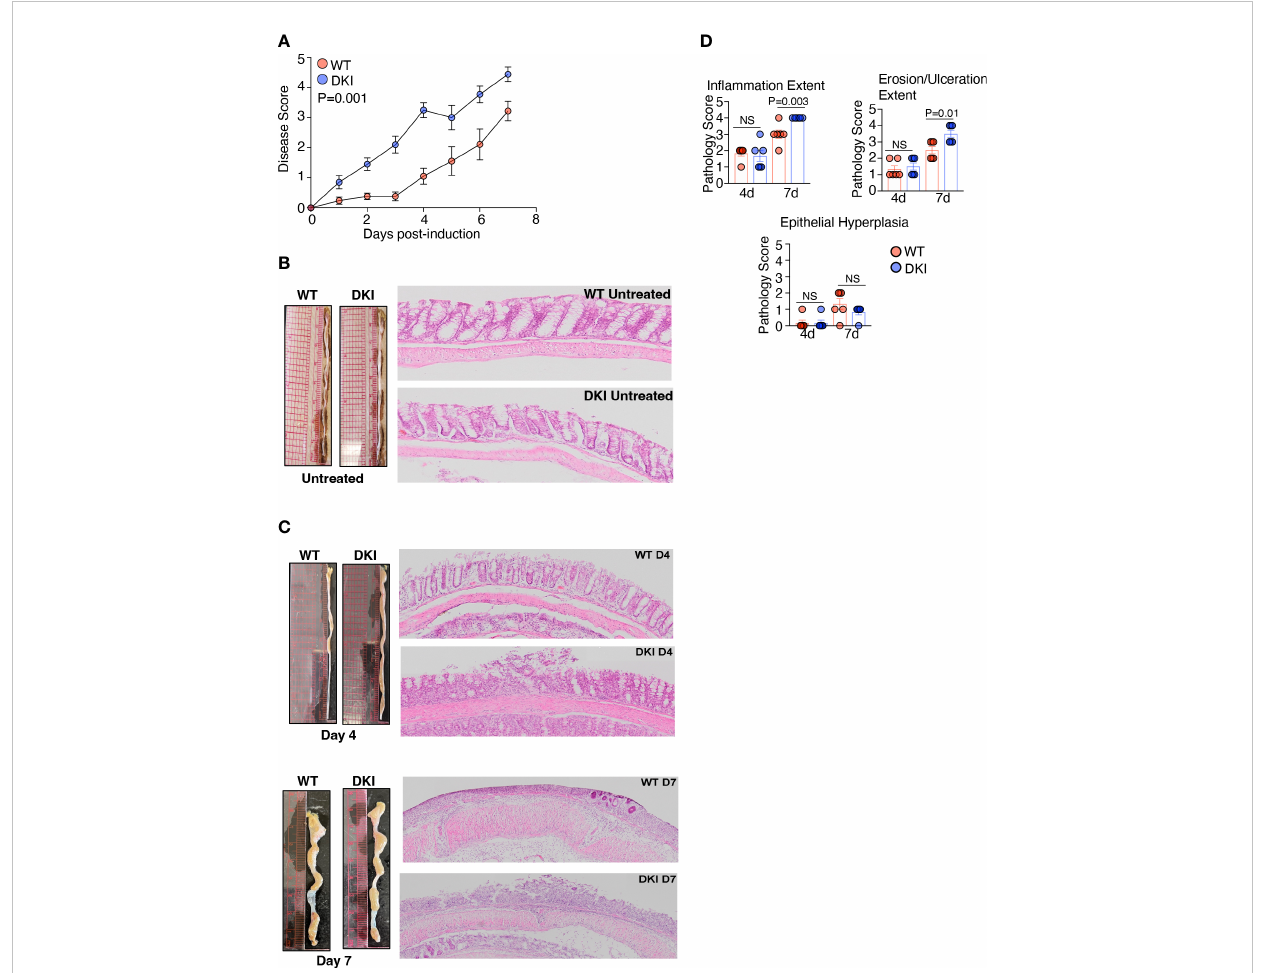
FIGURE 3 STAT5 Tetramers Prevent Serve Colitis Induced By DSS. (A-C) Colitis was induced in WT and DKI mice via the administration of 1% DSS to the drinking water. Colons were harvested on either day 4 or 7 post colitis induction. (A) Disease scores. n=21 for WT and 20 for DKI from 4 independent experiments. (B, C) Representative images and H&E staining of colons on (B) untreated mice (n=10) or (C) mice treated with DSS for 4 or 7 days. In (C) , Data are from 2 independent experiments per timepoint with n=6. (D) Pathological assessment of in fl ammation extent (total area of the colon presenting with in fl ammation), ulceration/erosion extent (total area of the colon presenting with ulceration/erosion), and epithelial hyperplasia. Data are from 2 independent experiments per timepoint with n=6. (A, D) Data shown are mean ± SEM. Statistical signi fi cance is indicated by the P-value with NS meaning no statistical signi fi cance. (A) Area under the curve with unpaired t test. (D) Unpaired t